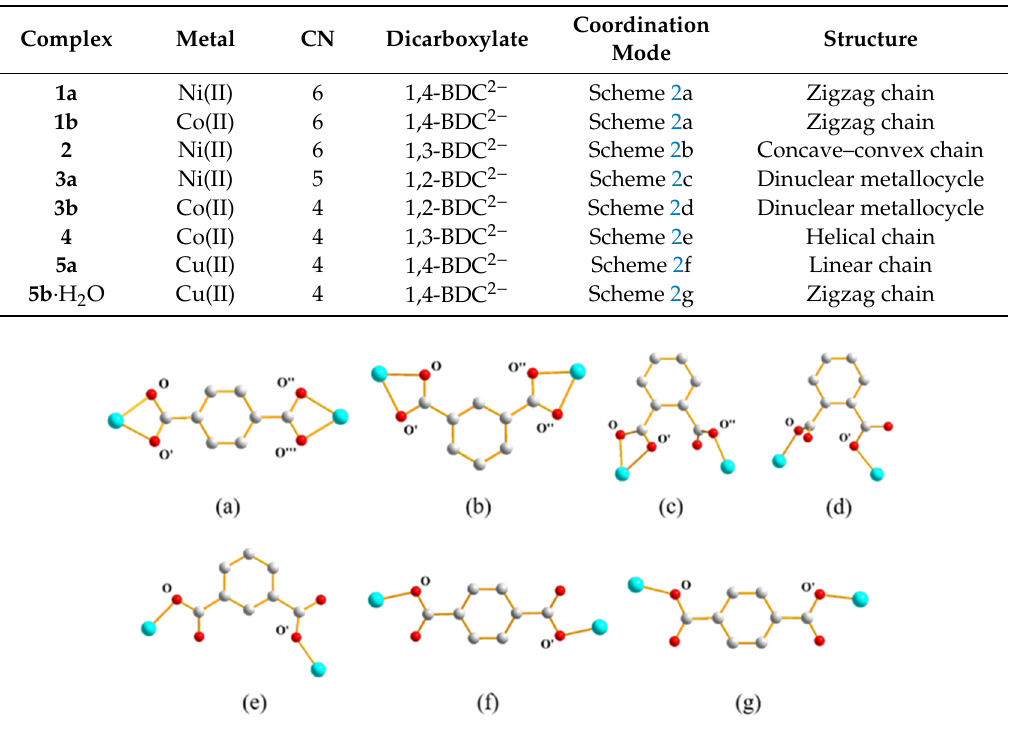
Table 2. Structural parameters of 1 – 5 .